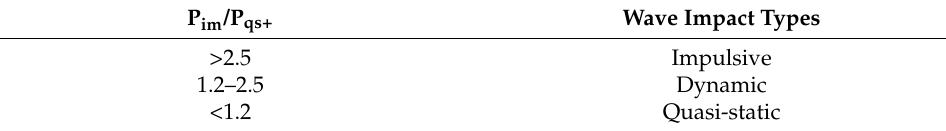
Table 3. Classification of wave impact types.